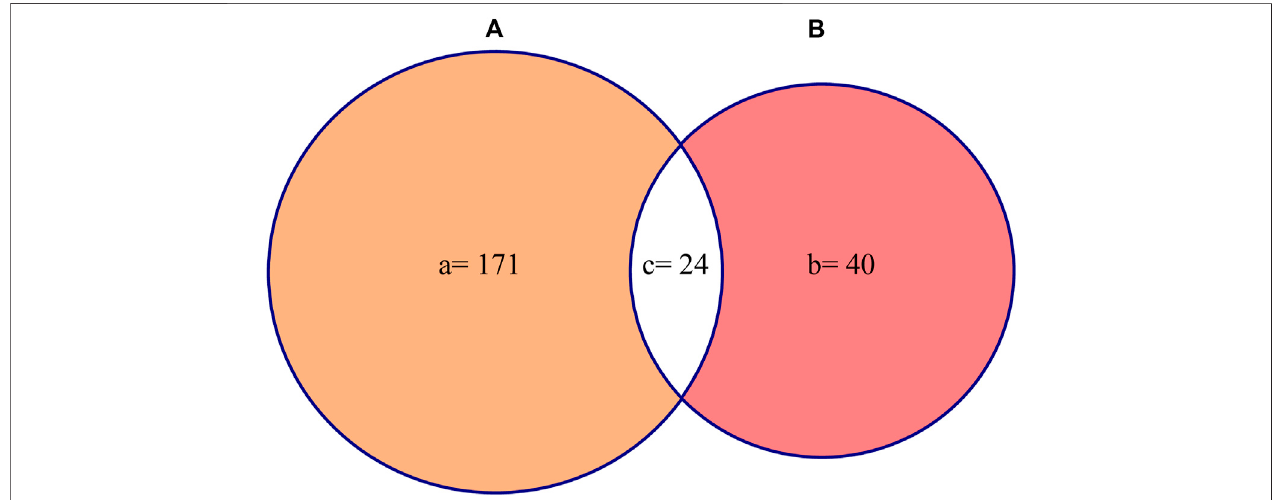
FIGURE 5 | Jaccard similarity index (A) represents plants used in vitro and (B) represents plants used in vivo .